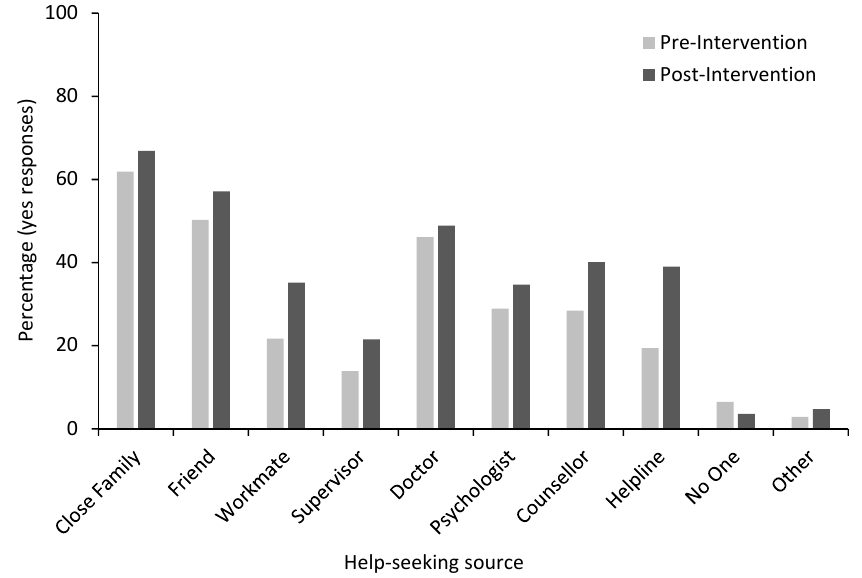
Figure 2. Percentages of help-seeking intentions by source (yes responses) pre- and post-intervention. Table 2. Fixed effect estimates for the predictors of suicide awareness, well-being and help-seeking